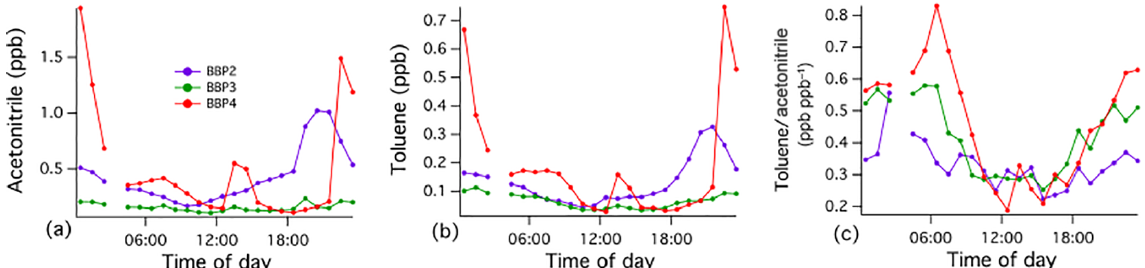
Figure 7. Mean hourly diurnal (a) acetonitrile concentration, (b) toluene concentration, and (c) toluene/acetonitrile ratio, separated into different biomass burning periods (BBP). All parts-per notation refers to mole